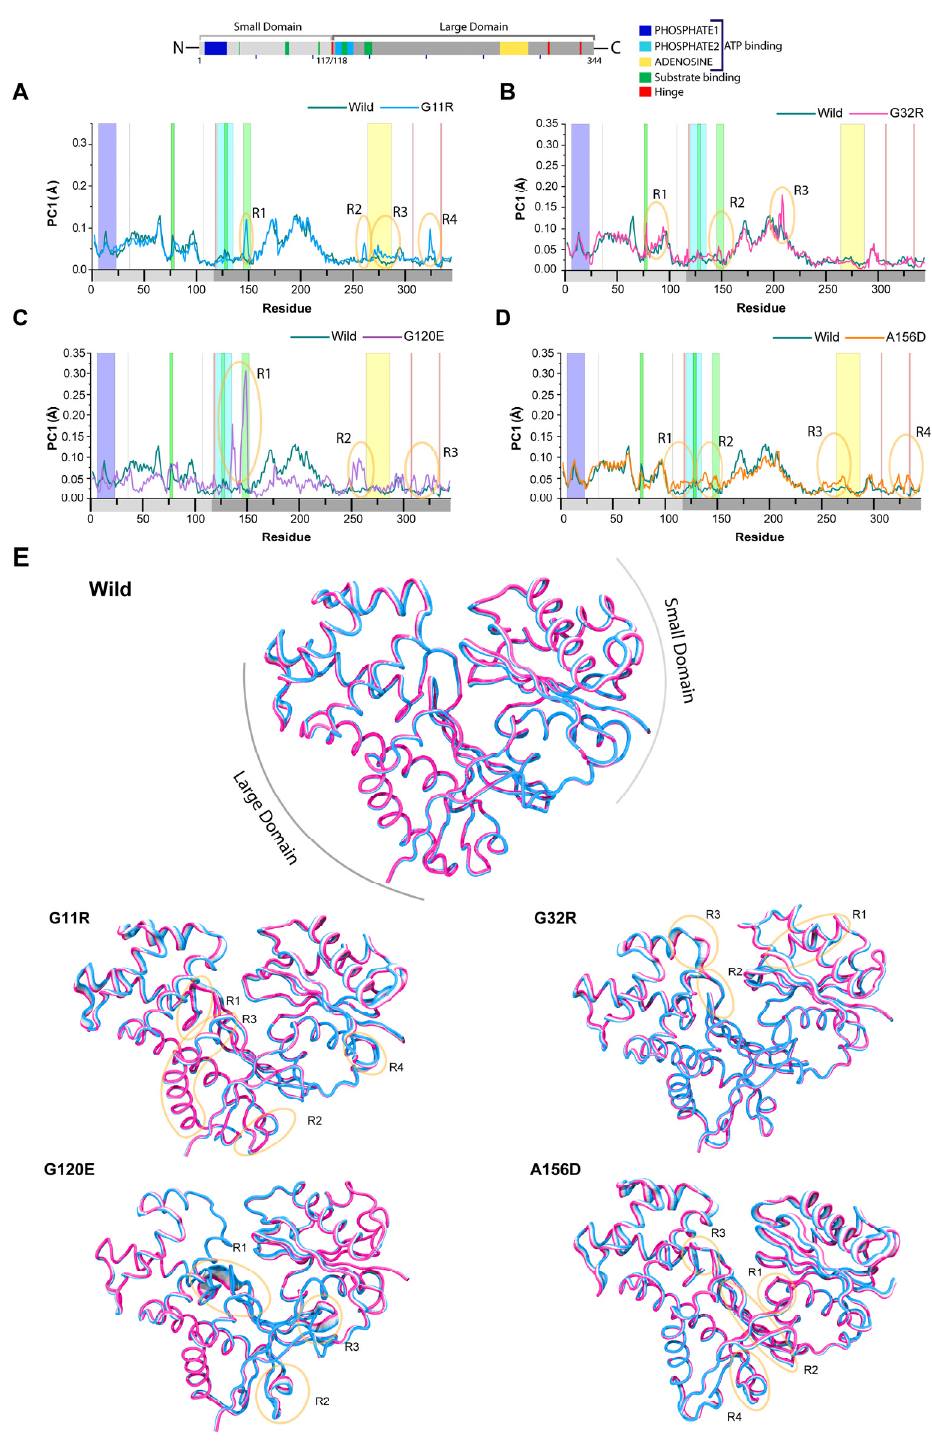
Figure 7. Variants induced changes in NAGK dynamical motion. Line plot showing the deviation between the first principal component of NAGK in variants (G11R ( A ), G32R ( B ), G120E ( C ), and A156D ( D )) and wild-type. ( E ) The alterations in atomic movements in PC1 are demonstrated by the tube model, where widen tube indicates an area with high flexibility marked by an orange circle.